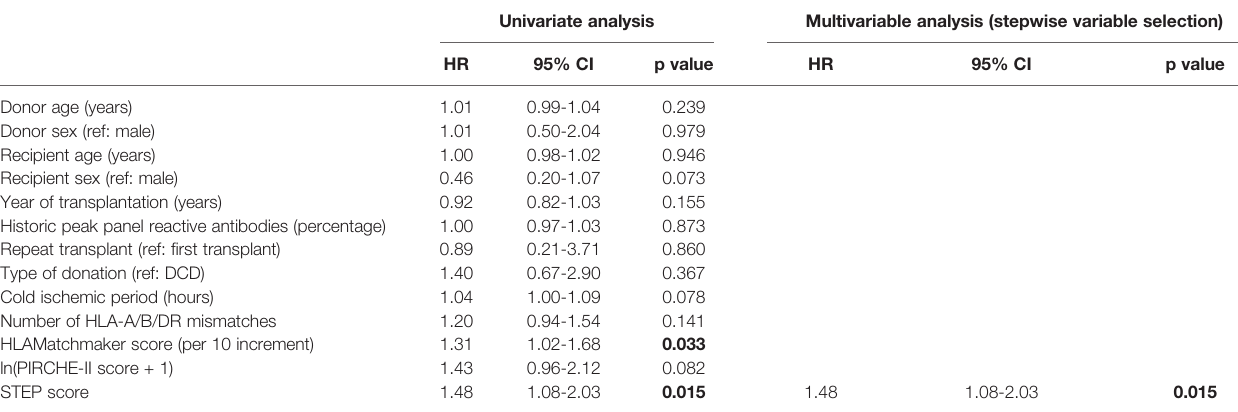
TABLE 2 | Univariate and multivariable Cox proportional hazards analysis of the effect of donor age, donor sex, recipient age, recipient sex, year of transplantation, historic peak panel reactive antibodies (hPRA), repeat transplant, type of donation [donation after brain death (DBD) or donation after circulating death (DCD)], cold ischemic period, number of HLA-A/B/DR mismatches, HLAMatchmaker score, ln(PIRCHE-II score + 1), and Shared T-cell EPitopes (STEP) score on the 10-year risk of death-censored graft